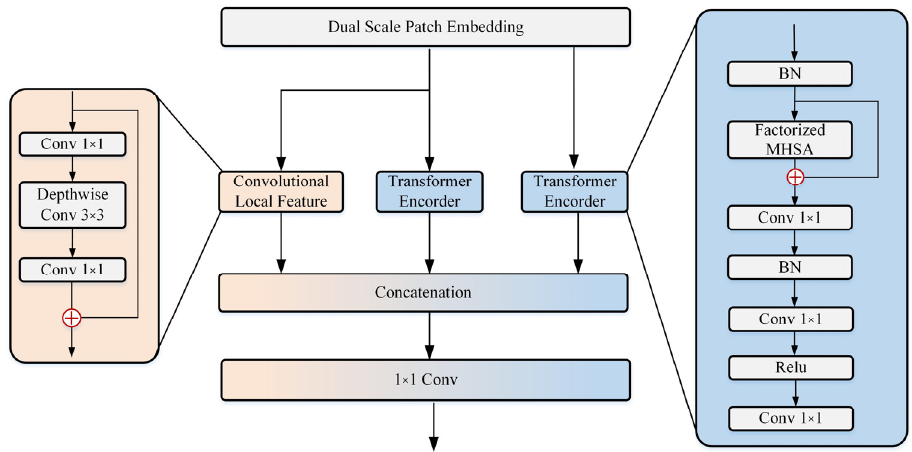
Figure 3. Overview of Dual Path Transformer Block. Among Q , K , V ∈ R N × C is the queries, keys, and values of the linear projection. N and C represent the number and embedded dimension of tokens, respectively. If there is no convolution position coding, the Transformer is only composed of the self-attention module, which will result in the model being unable to obtain the difference of local features, and this feature cannot be applied to the sonar image target detection task with large background noise. In order to be able to better integrate CoaT into DP-ViT, according to the class token and image token in ViT [15]. We use 2-D depthwiseconv convolution, which is only